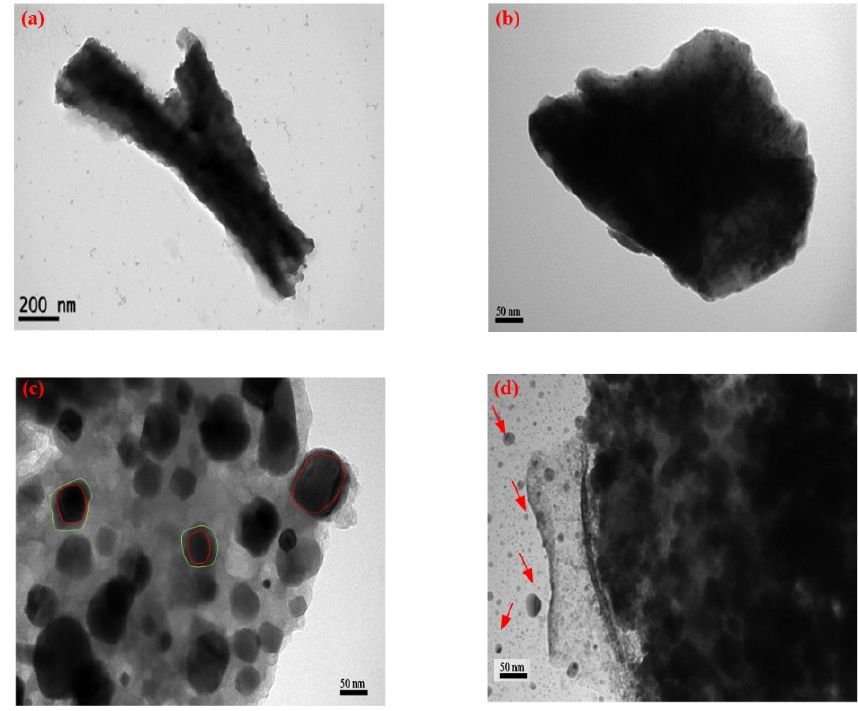
Figure 6. TEM micropictures of ( a ) PANI(EB)-Em/Fe 3 O 4 (OA), ( b ) PANI(EB)/Fe 3 O 4 (OA), ( c ) FeNC- 950, ( d ) Ground FeNC-950.